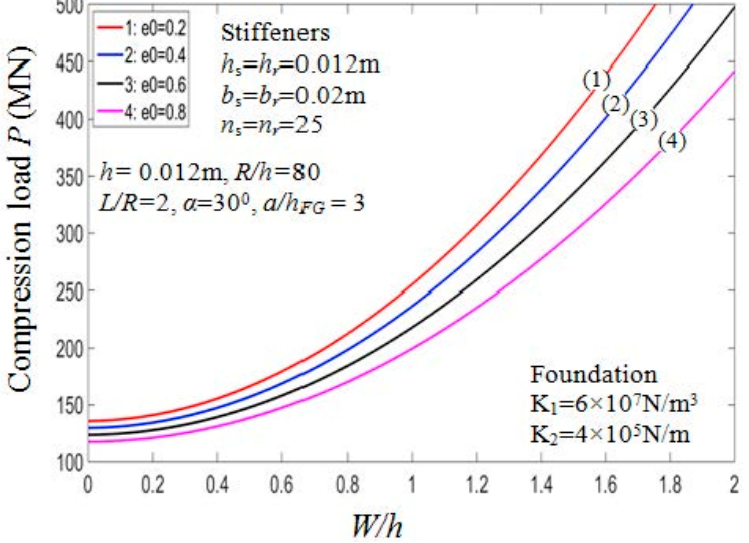
Figure 4. Effects of e 0 on postbuckling load—deflection curves (Outside stiffener, k 2 = k 3 = k = 1).